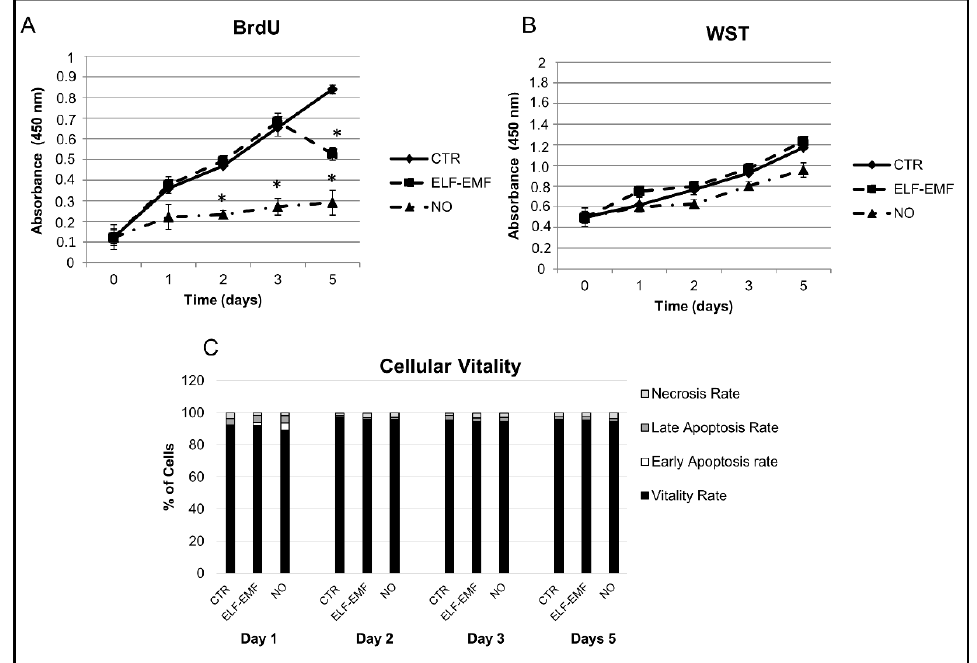
Figure 2. hAMSCs’ metabolic activity (WST assay), cell proliferation (BrdU incorporation assay) and cellular vitality study: ( A ) cell proliferation analysis in hAMSCs control sample (CTR), in 5 days 7 Hz, 2.5 μT exposed cells (ELF‐EMF) and in 5 days 0.4 mM Nitric Oxide (NO) treated cells; ( B ) metabolic